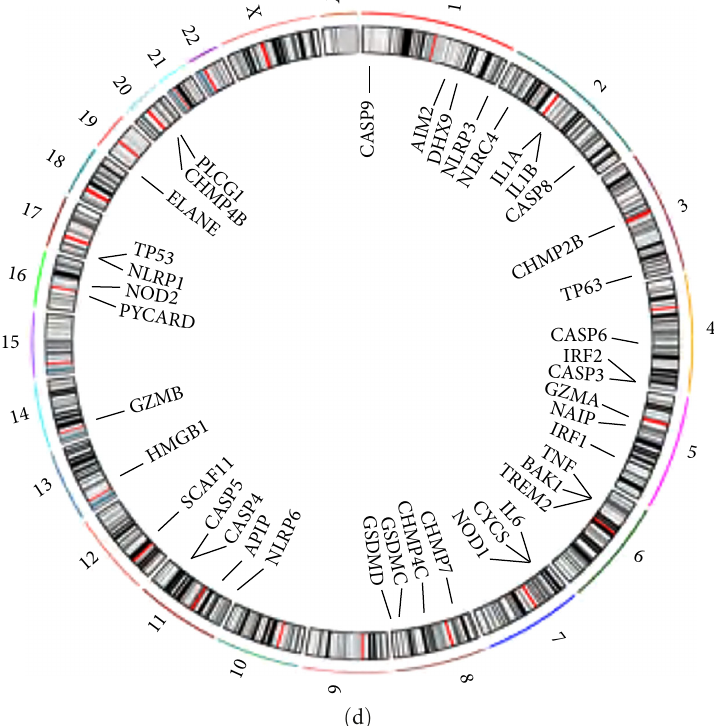
F IGURE 2: Landscape of the PRGs. (a, b) The volcano map and the histogram showed the expression distributions of 53 PRGs between healthy and periodontitis samples. (c) The heat map presented the expression status of 48 distinct PRGs between healthy and periodontitis samples. (d) Chromosomal locations of the 53 PRGs. ∗ p < 0 : 05, ∗∗ p < 0 : 01, and ∗∗∗ p < 0 : 001. PRG, pyroptosis-related